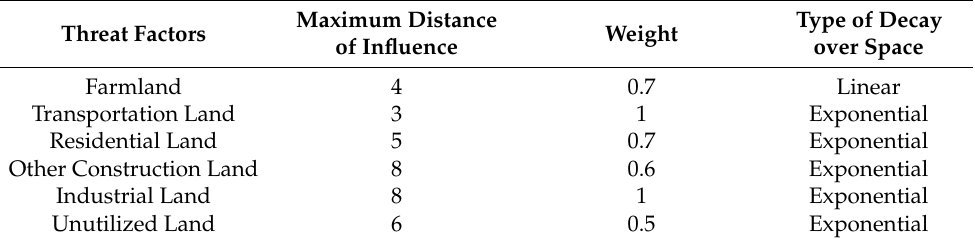
Table 2. Threat factors and their maximum distance of influence, weight, and type of decay over space.